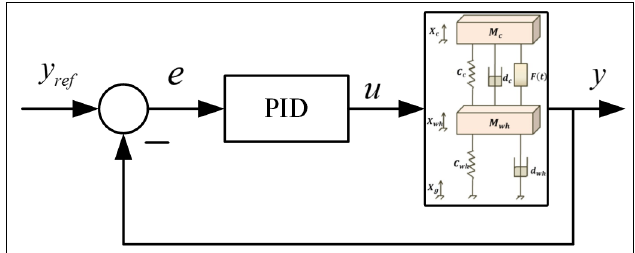
Figure 3. Block diagram of PID controller